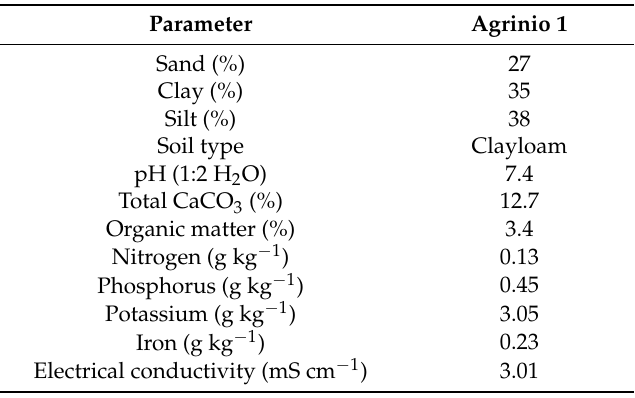
Table 1. The physical and chemical properties of the soil in the experimental field.